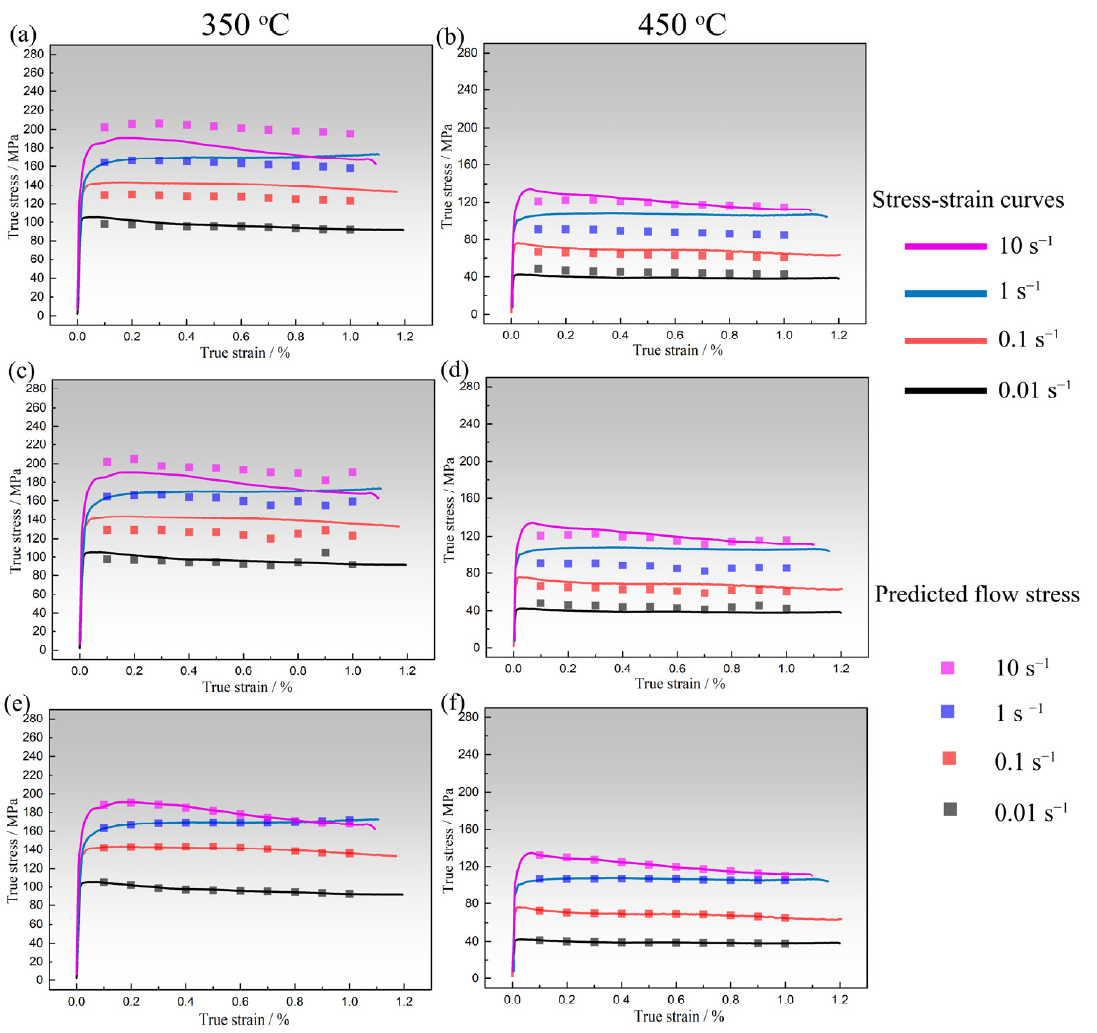
Figure 13. Stress − strain curves and predicted values of ( a ) constitutive equation at 350 °C, ( b ) constitutive equation at 450 °C, ( c ) strain − compensated constitutive equation at 350 °C, ( d ) strain − compensated constitutive equation at 450 °C, ( e ) ANN at 350 °C, and ( f ) ANN at 450 °C.